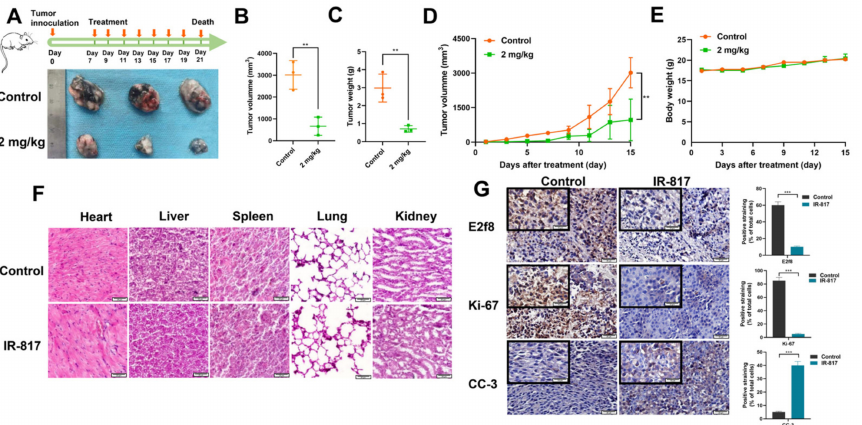
Figure 8. Antitumor evaluation of IR-817 in vivo. ( A ) Schematic of the experimental design in vivo and physical image of the resected transplanted tumor (n = 3 in each group). ( B ) Tumor vol- ume. ( C ) Tumor weight. ( D ) Tumor growth curve of the mice. ( E ) Body weight change of mice. ( F ) H&E staining images of the heart, liver, spleen, lung, and kidney of the mice. ( G ) E2f8, Ki67, CC-3 im- munohistochemical staining in the sectioned tumors ** p < 0.01, *** p < 0.001 compared with the control